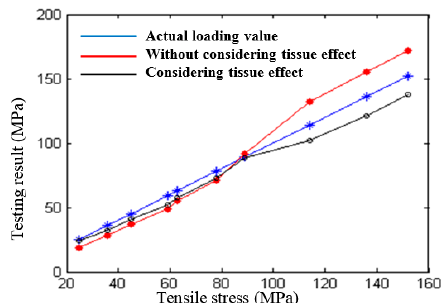
Figure 5. Stress testing results of Fe314 laser cladding coating [51]. “Reproduced with permission from published by © Springer.” (2015).